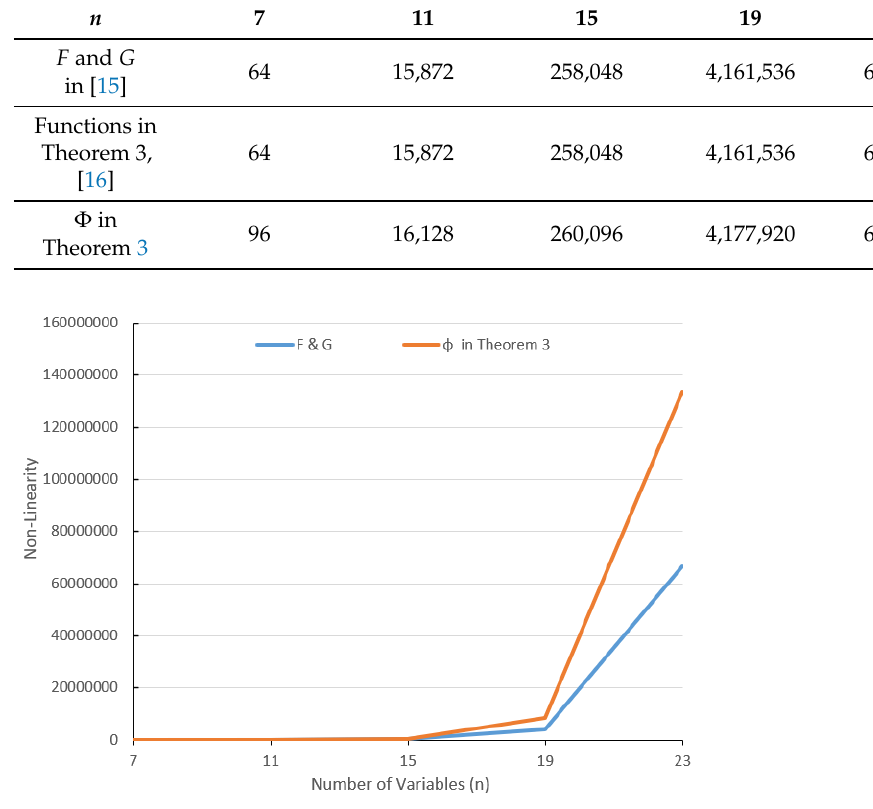
Figure 1. Nonlinearity of function Φ in Theorem 3, and F and G in